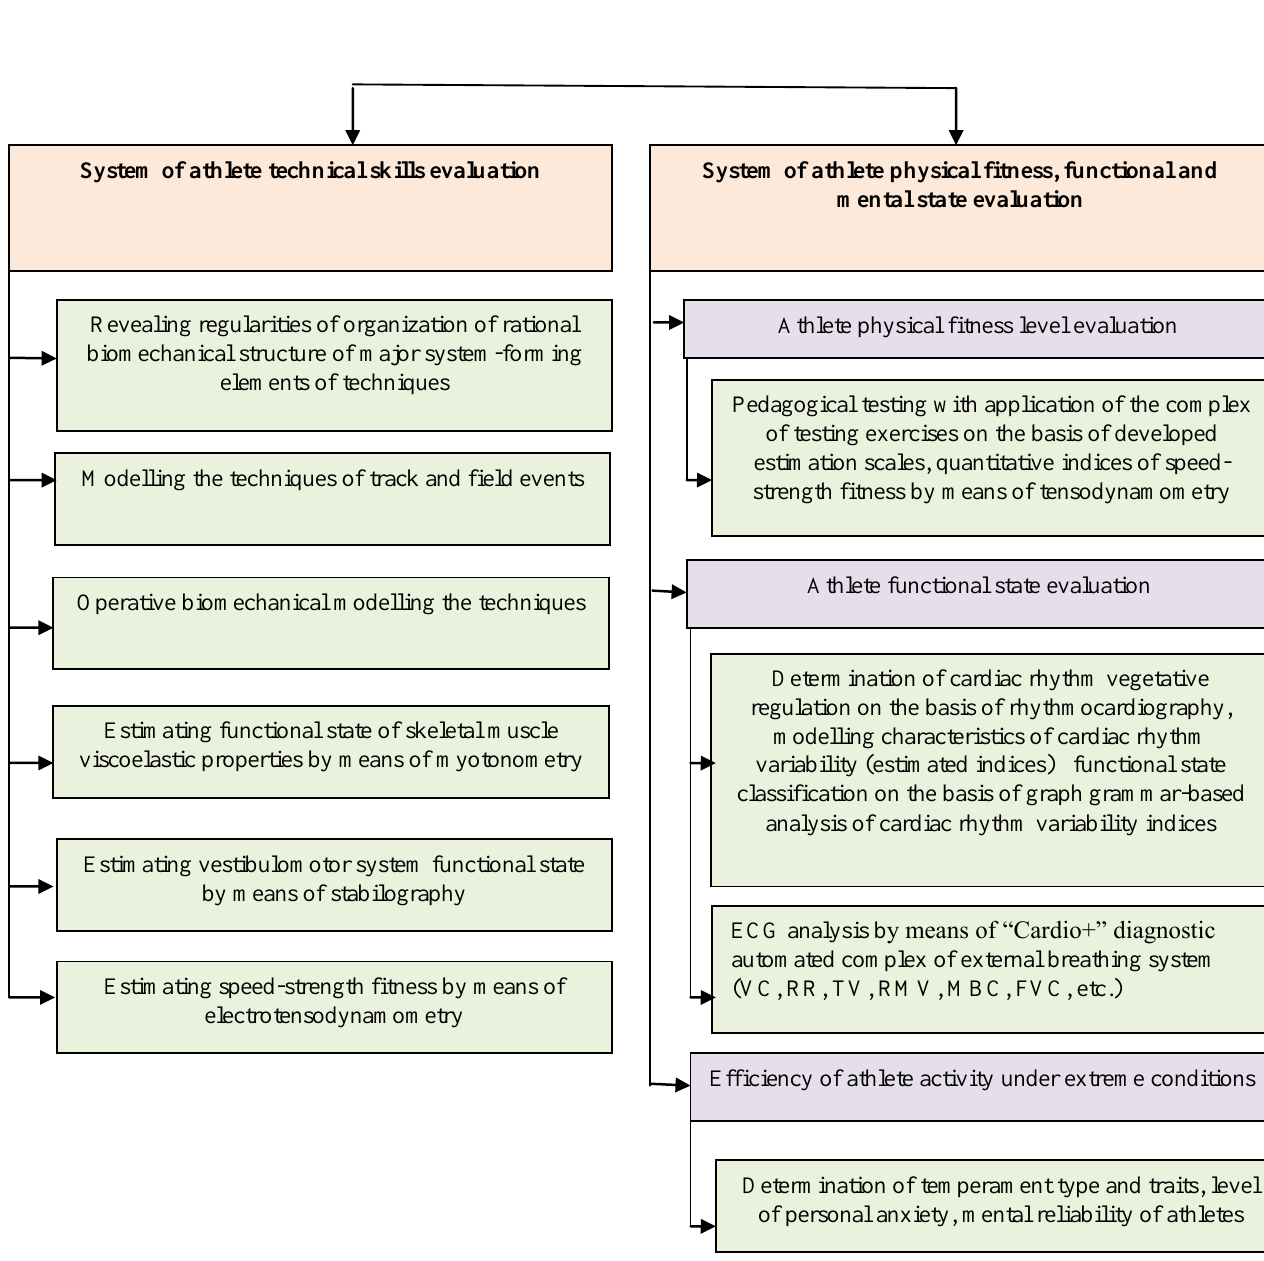
Fig. 8. Structure of studying training and competitive activity athletes’ state in track and field состояния